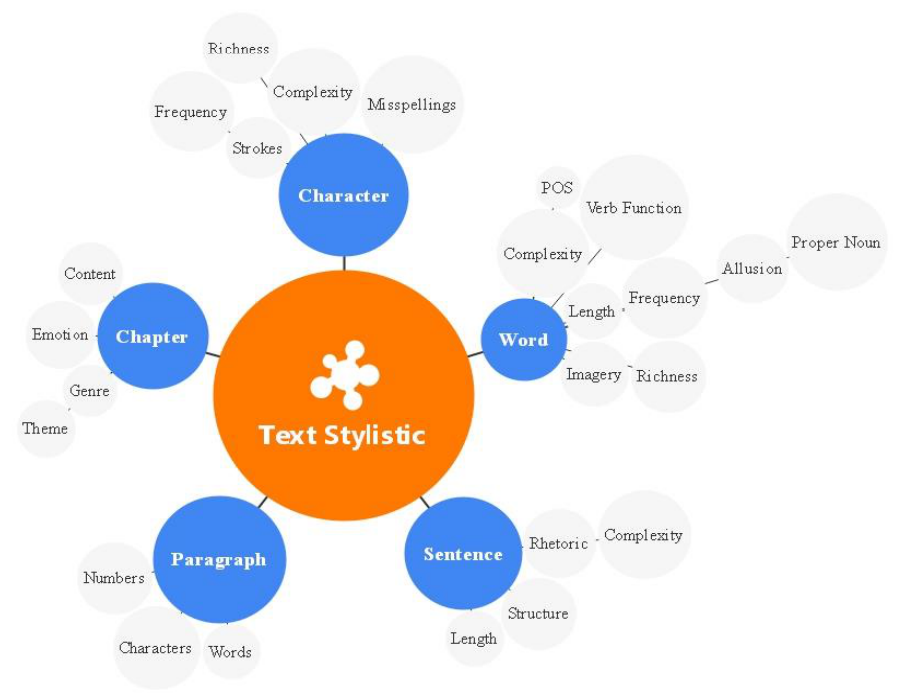
Figure 4. Description of stylistic text features for poetry in Tang Dynasty.